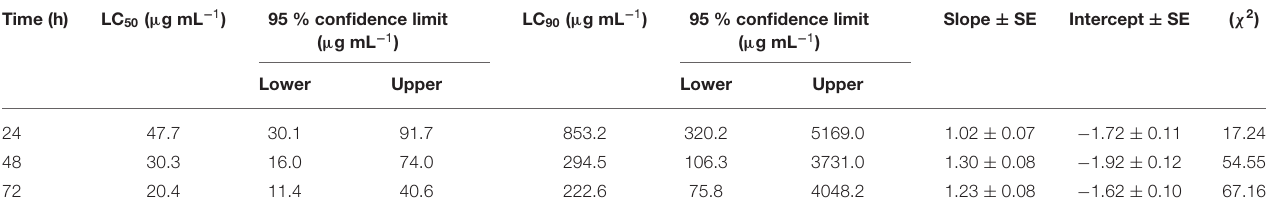
TABLE 1 | Probit analysis of the mortality data of Meloidogyne incognita to mustard essential oil (MEO) at different time intervals. Time